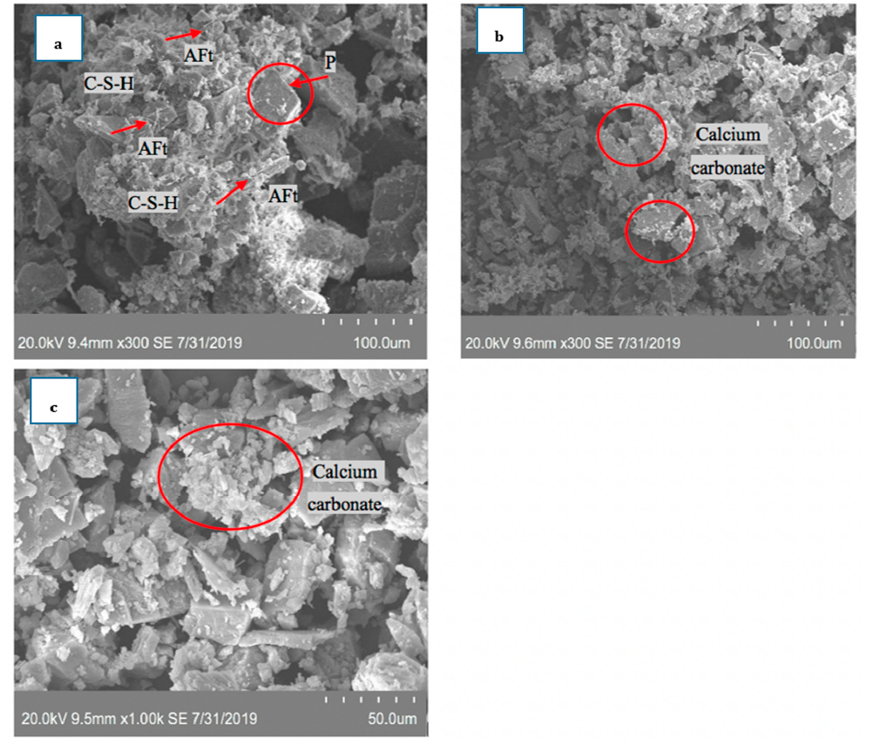
Figure 9. SEM morphology of aggregates in brick specimens: ( a ) uncarbonated brick, ( b ) 3 h carbonated brick at ×300 magnification, and ( c ) 3 h carbonated brick at ×1.00 k magnification.